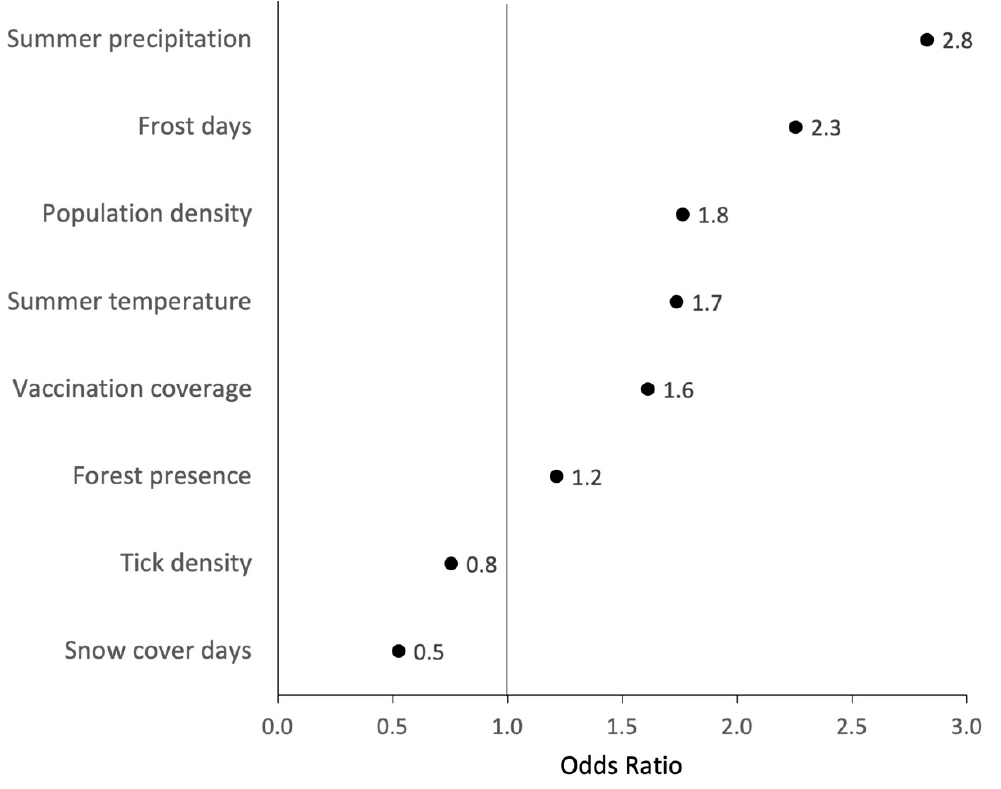
Figure 4. Direction and magnitude of effect of each covariate in determining the probability of the presence of a POI; comparing the 25% to the 75% percentile of each model covariate while keeping all other variables at the median value; raw odds ratios (ORs) and 95% confidence intervals (95% CI) are displayed in Table S2.